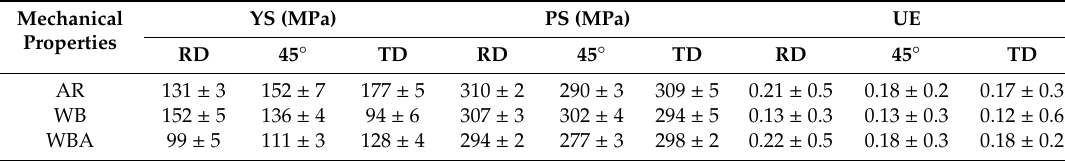
Figure 8. True stress–strain curves of ( a ) AR sample, ( b ) WB sample and ( c ) WBA sample. Table 1. Yield strength (YS), peak strength (PS) and uniform elongation (UE) of various samples.